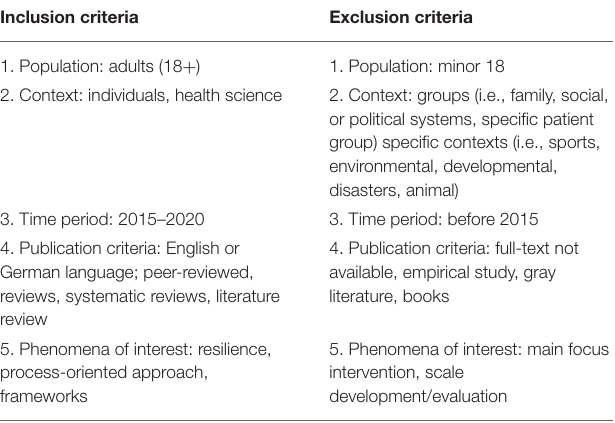
TABLE 1 | Inclusion and exclusion criteria based on